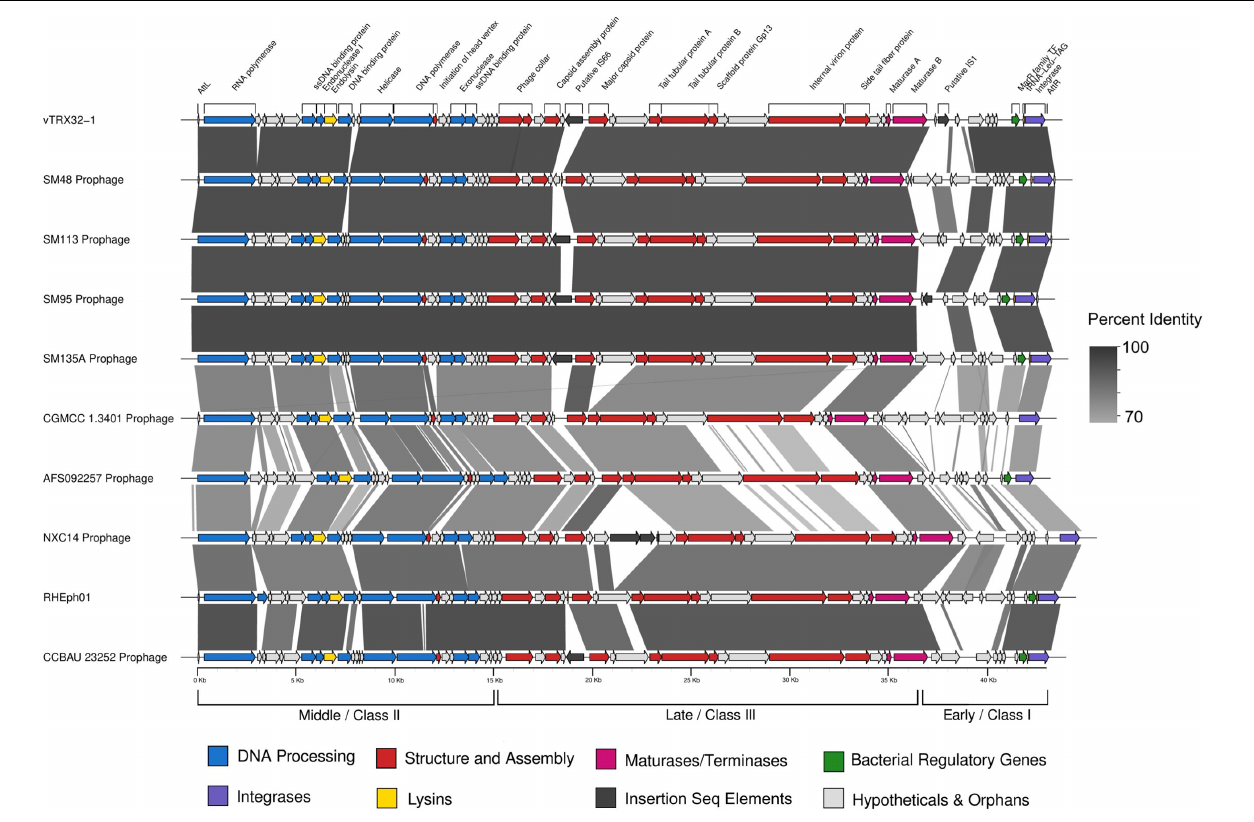
FIGURE 3 | Genome comparison of vTRX32-1 and related phage/prophage. Blastn hits are represented by gray bars, with darker shades of gray indicating higher percent identity. Genomes are organized from top to bottom based on the phage phylogeny. Genes are colored according to their